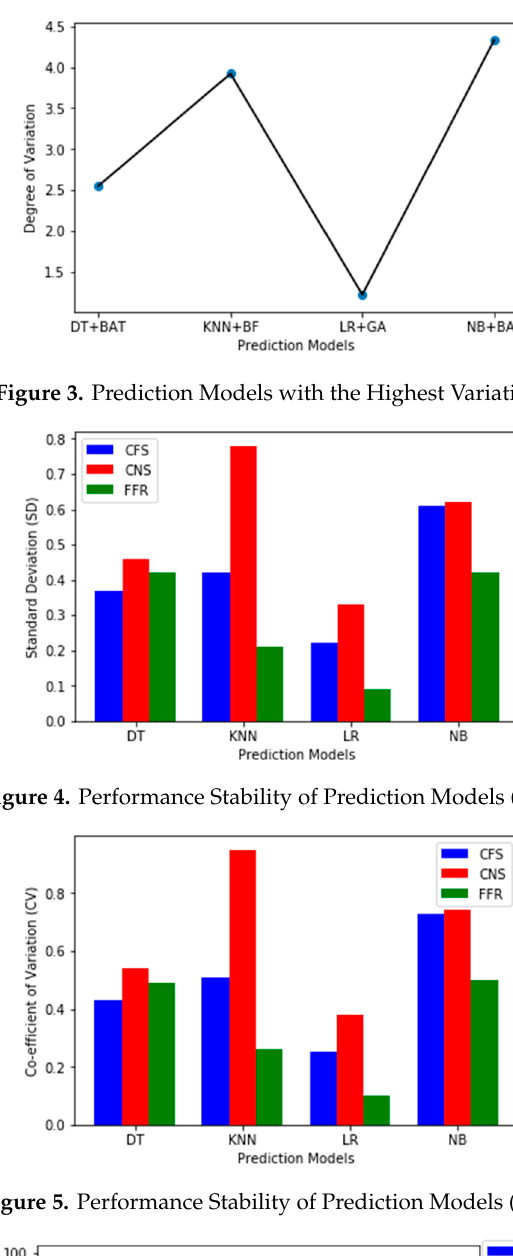
Figure 4. Performance Stability of Prediction Models (SD). Figure 5. Performance Stability of Prediction Models (CV). Figure 6. Performance of Feature Selection Method on each Dataset.